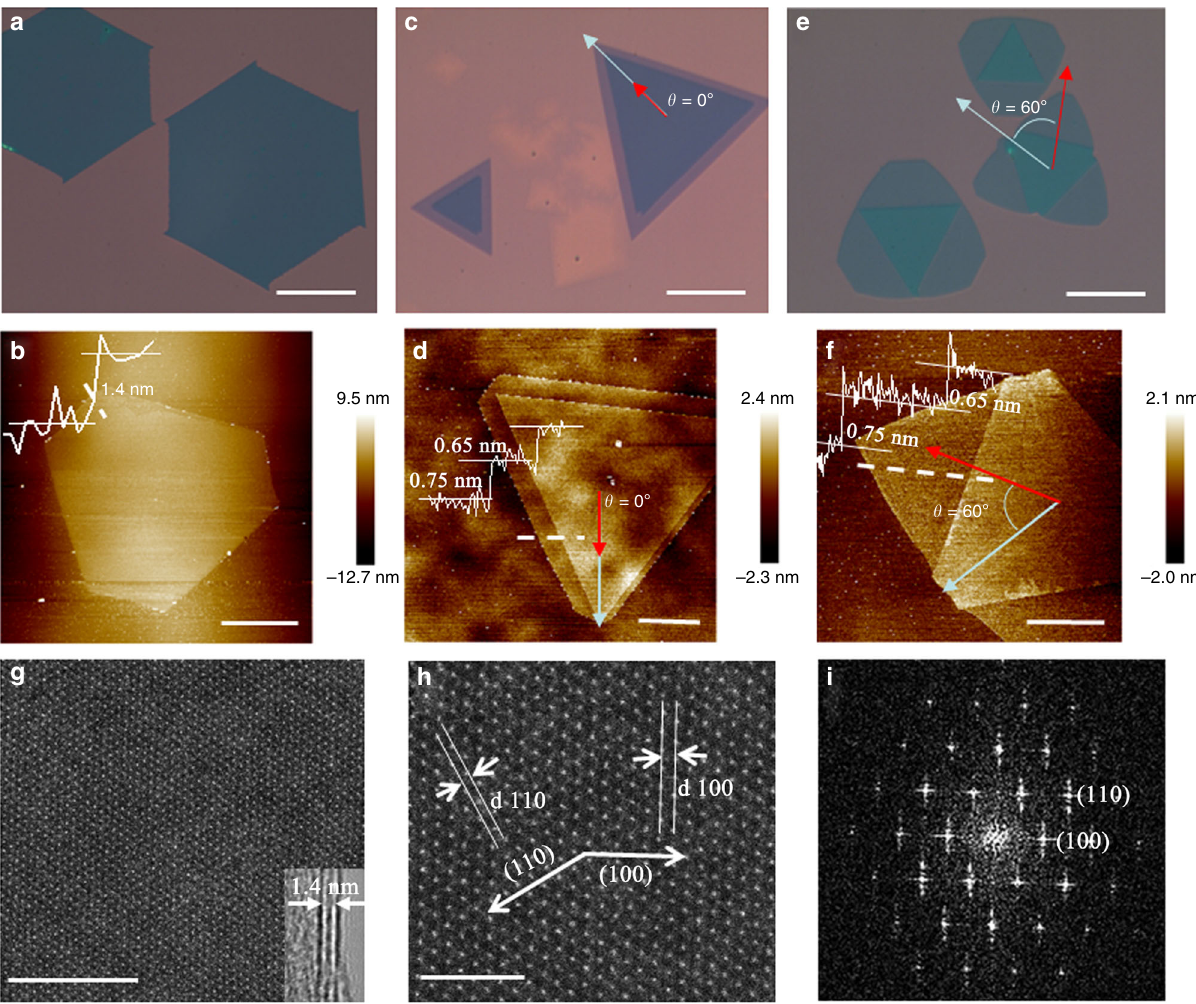
Fig. 2 Characterization of the bilayer MoS 2 crystals. a A representative optical microscope image and b a representative AFM surface morphology image of the as-grown AA stacking bilayer MoS 2 samples with the maximum lateral size of even up to 300 μ m. c A representative optical image and d a representative AFM surface morphology picture of the AA stacking bilayer MoS 2 grains with distinct steps, where the twist angle from the relative rotation of the two vertically stacked triangles θ = 0° indicate the AA stacking order 37,62,63 . e A typical optical image and f a typical AFM surface morphology image of the as-grown AB stacking bilayer MoS 2 samples, where the twist angle from the relative rotation of the two vertically stacked triangles θ = 60° indicate the AB stacking order 37,62,63 . Planar TEM images of the AA stacking bilayer MoS 2 crystals: g low resolution and h high resolution as well as i the FFT pattern. The inset in g shows the folded edge of MoS 2 bilayer fi lms. Scale bars, 100 μ m in a , c , and e , 20 μ m in b , 2 μ m in d , 5 μ m in f , 5 nm in g ,